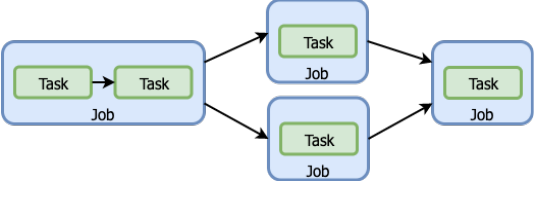
Fig. 1. An example workflow showing how it is built up from jobs, with dependencies between them, where each job consists of one or more